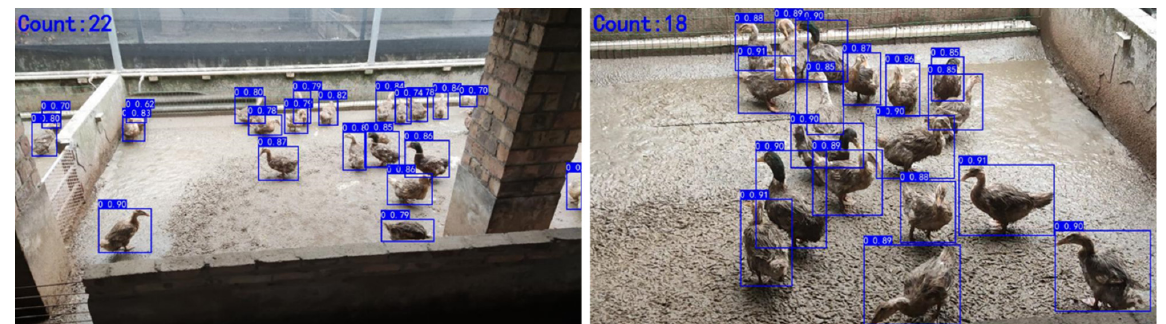
Figure 11. Prediction results of two annotation methods.